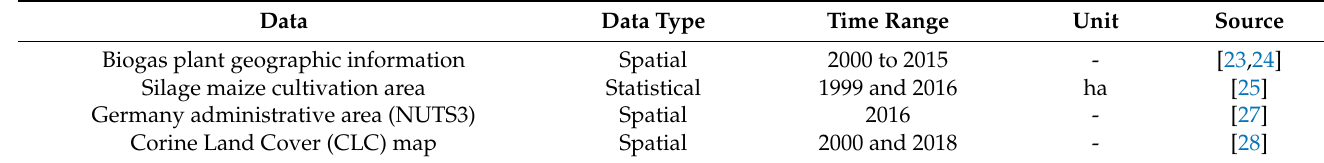
Table 2. Summary of the collected data for spatial analysis. NUTS, Nomenclature of Territorial Units for Statistics.